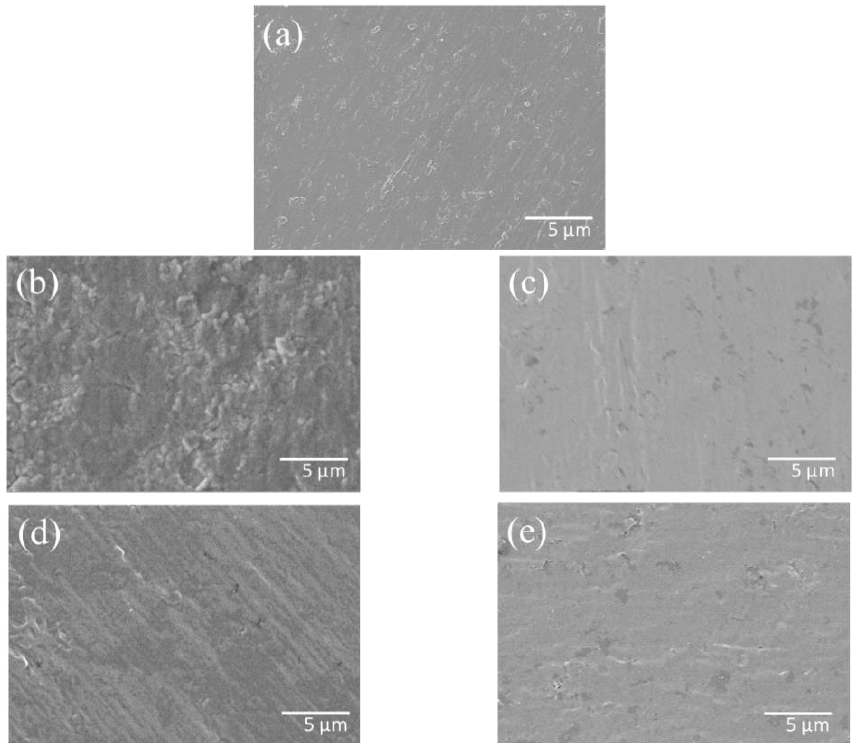
Figure 3. SEM micrographs of uncoated titanium surface ( a ) and DLC film-coated titanium deposited at CH 4 /H 2 = 1:1 ( b ); CH 4 /H 2 = 1:1 ( c ); CH 4 /H 2 = 1:0 ( d ); CH 4 /H 2 = 1:0 ( e ), with the deposition times of 6 h, 12 h, 6 h and 12 h, respectively.